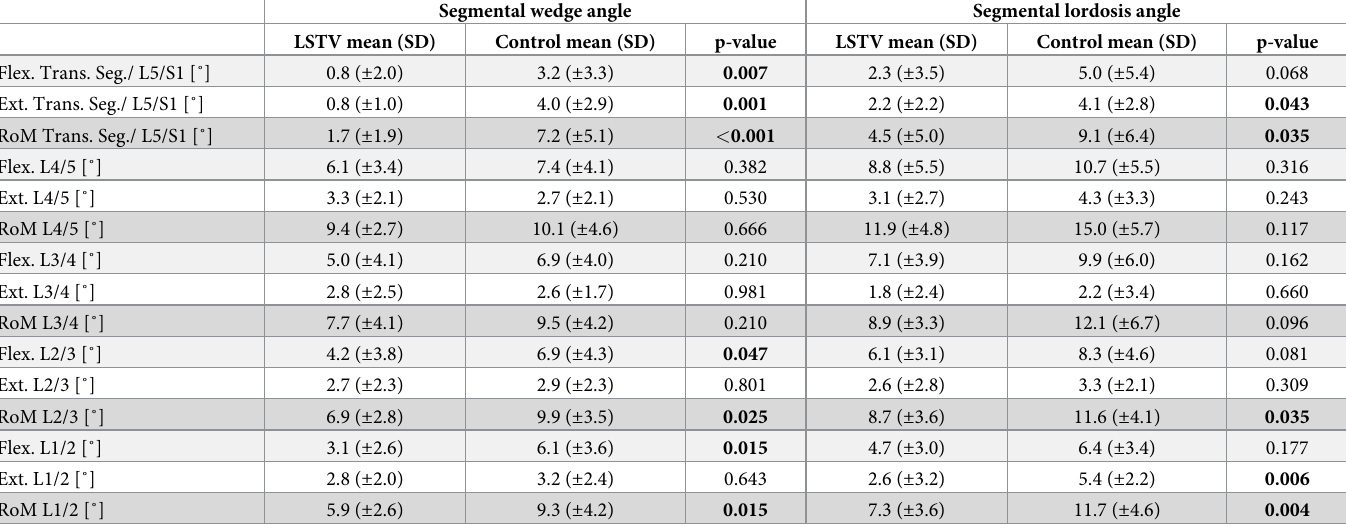
Table 3. Segmental lumbar lordosis range of motion in patients with LSTV and control